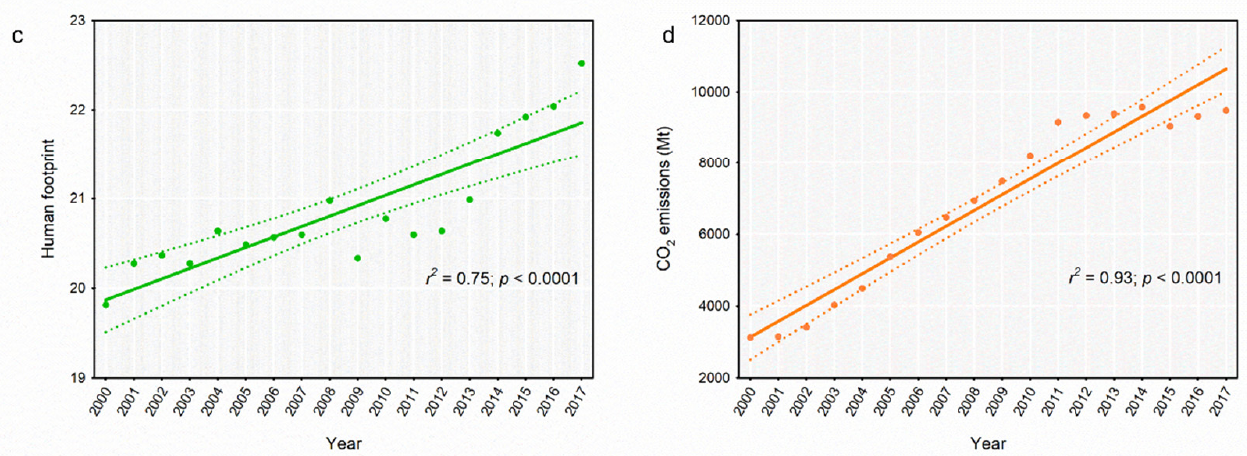
Figure 1. Features of human footprint and CO 2 emissions in China including ( a ) area of different human footprint classes, ( b ) variation in the average human footprint in different years, ( c ) regression analysis of human footprint and time, and ( d ) regression analysis of CO 2 emissions and time.